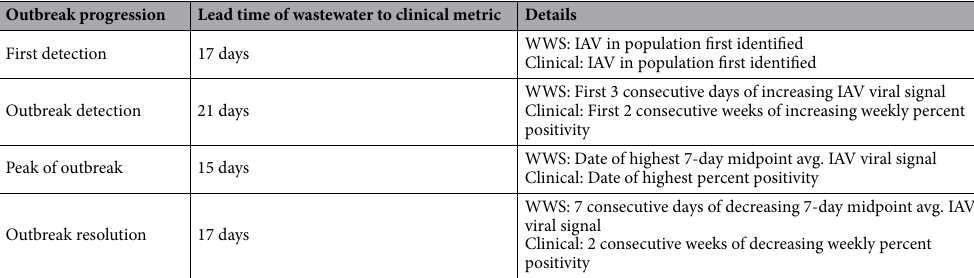
Table 1. Lead time of normalized IAV viral RNA signal to weekly IAV percent